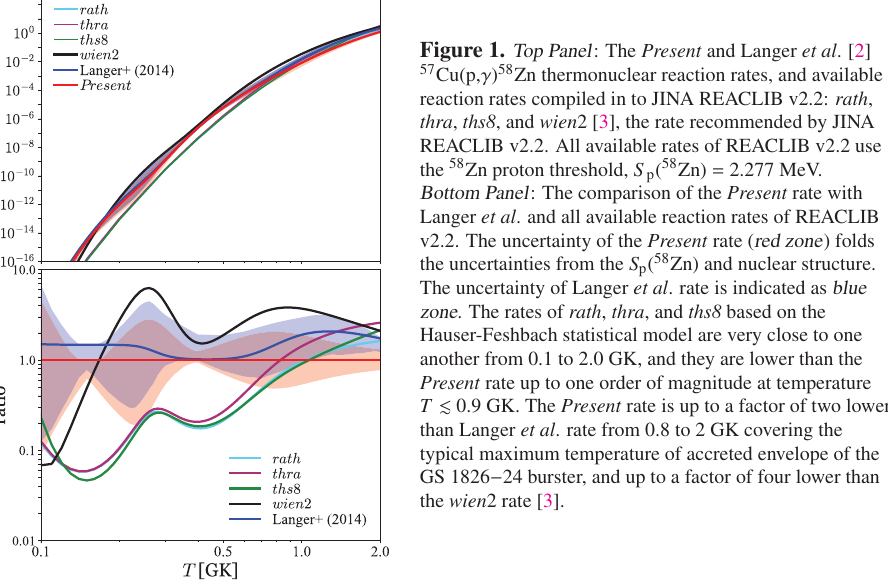
Figure 1. Top Panel : The Present and Langer et al . [2] 57 Cu(p, γ ) 58 Zn thermonuclear reaction rates, and available reaction rates compiled in to JINA REACLIB v2.2: rath , thra , ths8 , and wien 2 [3], the rate recommended by JINA REACLIB v2.2. All available rates of REACLIB v2.2 use the 58 Zn proton threshold, S p ( 58 Zn) = 2.277 MeV. Bottom Panel : The comparison of the Present rate with Langer et al . and all available reaction rates of REACLIB v2.2. The uncertainty of the Present rate ( red zone ) folds the uncertainties from the S p ( 58 Zn) and nuclear structure. The uncertainty of Langer et al . rate is indicated as blue zone . The rates of rath , thra , and ths8 based on the Hauser-Feshbach statistical model are very close to one another from 0.1 to 2.0 GK, and they are lower than the Present rate up to one order of magnitude at temperature T (cid:2) 0.9 GK. The Present rate is up to a factor of two lower than Langer et al . rate from 0.8 to 2 GK covering the typical maximum temperature of accreted envelope of the GS 1826 − 24 burster, and up to a factor of four lower than the wien 2 rate